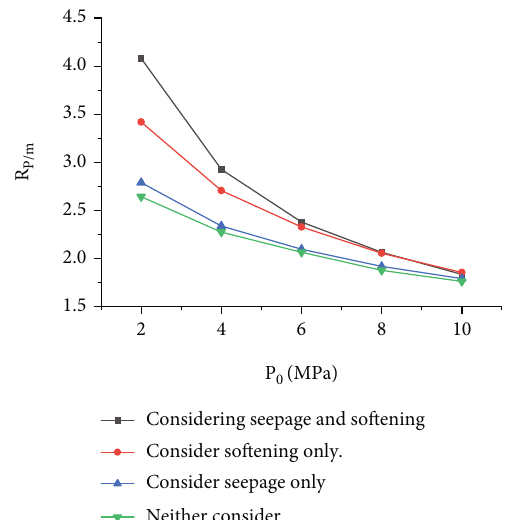
Figure 6: Relationship curve between P